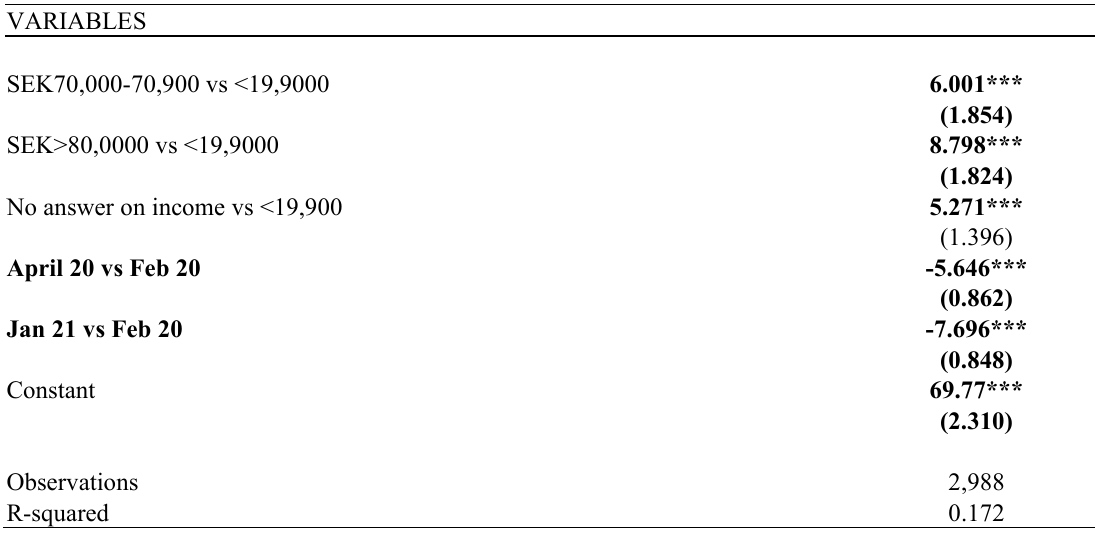
Table 2: Regressions of HRQoL on VAS scale, Pooled samples (continued)